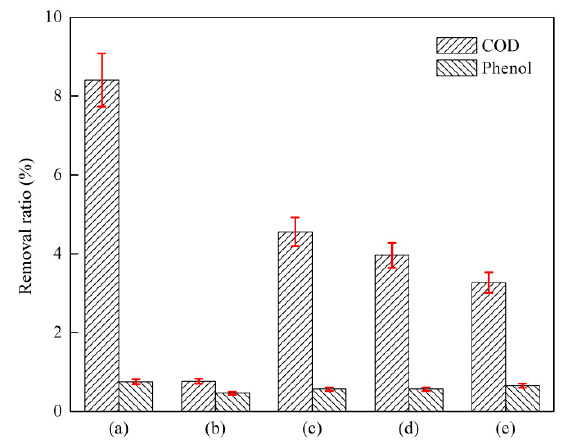
Figure 8. E ff ect of composite coagulant on coagulation and sedimentation treatment of coking wastewater ( a ) polyferric sulfate (PFS); ( b ) polyaluminum chloride (PAC); ( c ) PFS: Polyacrylamide (PAM) = 5:1; ( d ) PFS:PAM = 10:1; ( e ) PFS:PAM = 15:1).